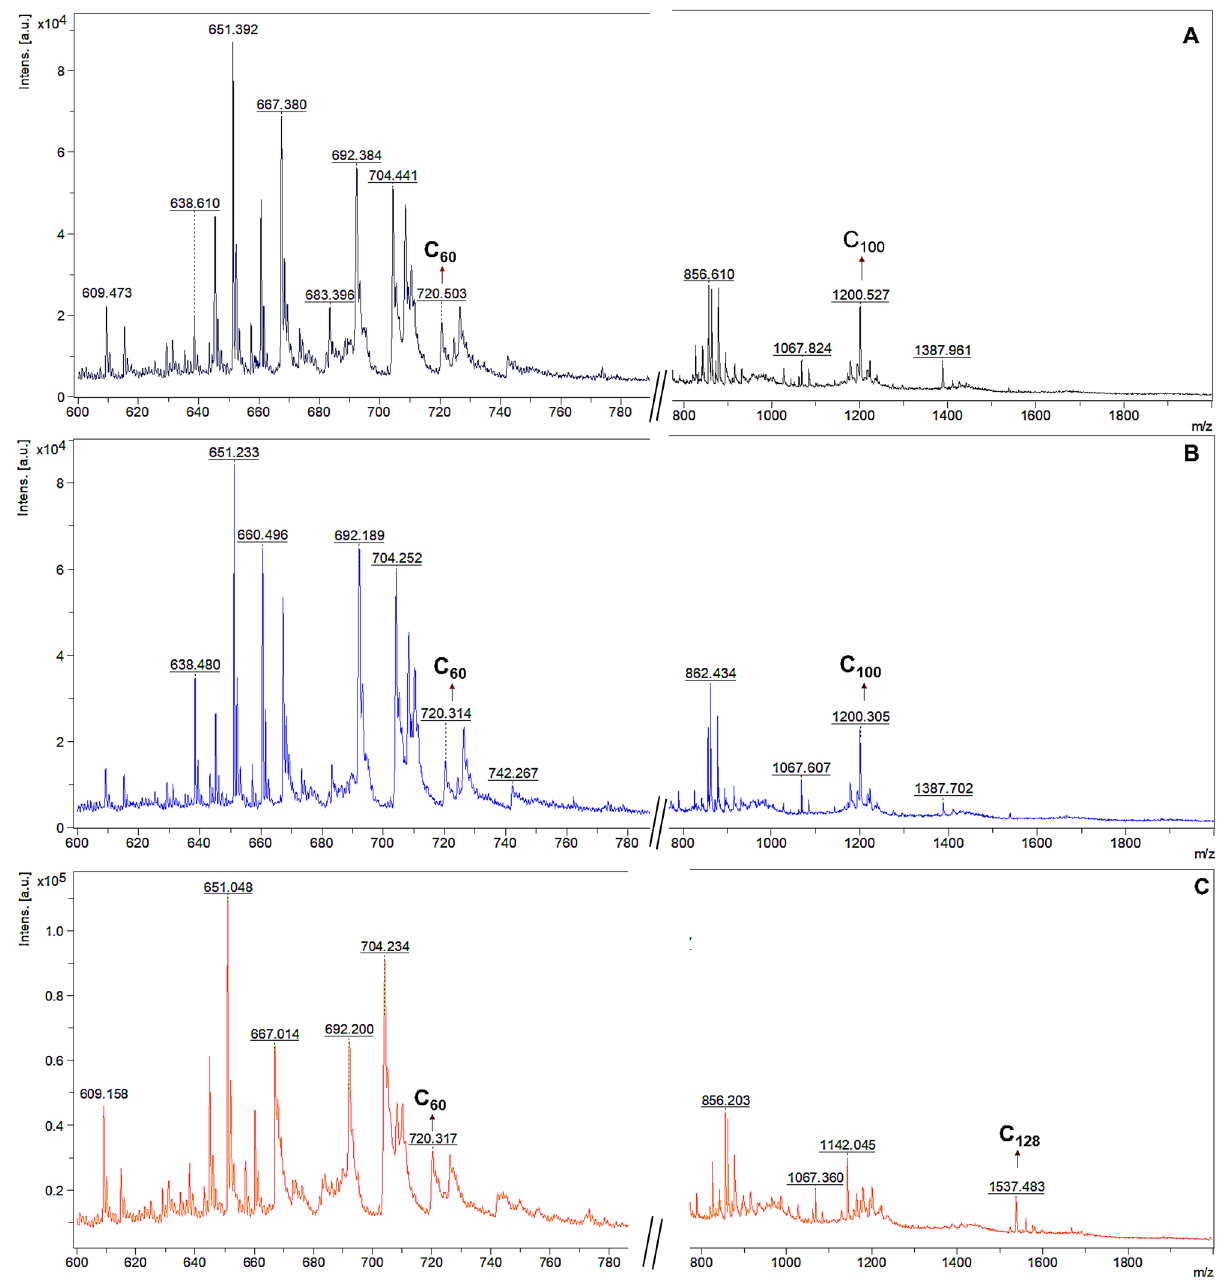
observed as the ion with m/z 720 (C60) using the CHCA